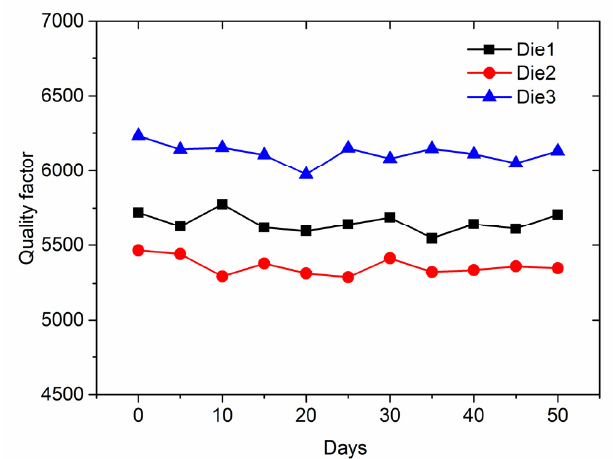
Figure 13. Response of the microsensor versus the applied electric field in three roundtrip measure- ments.